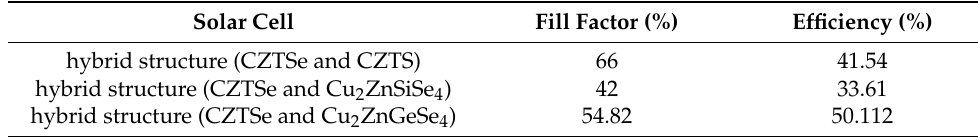
Table 3. Comparation results of hybrid solar cells.